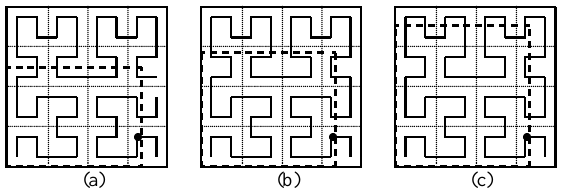
Fig. 6: For subgrids overlapping with all quadrants of a canonical H 2 q , their last exits are the same.